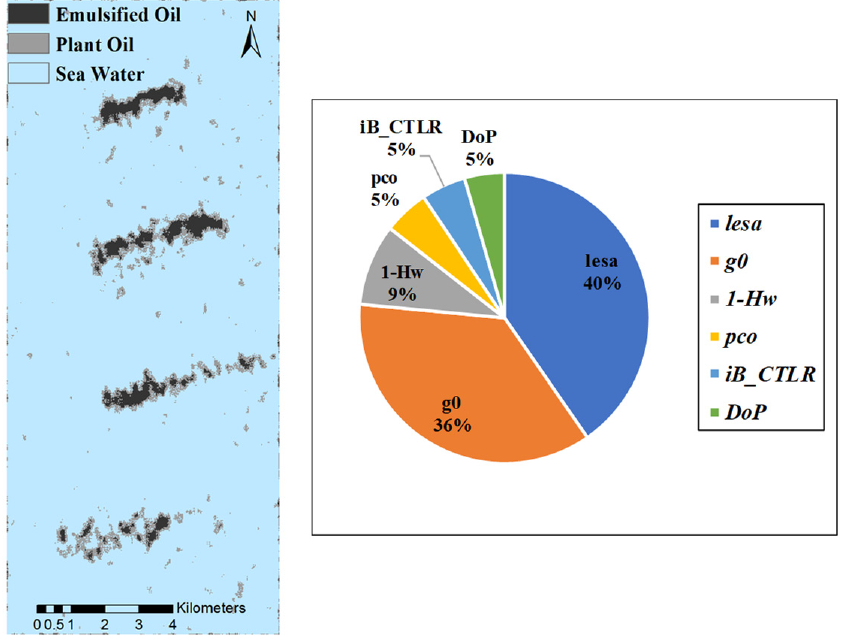
Figure 17. Random forest classification result graph and variable importance ranking for Case 4.